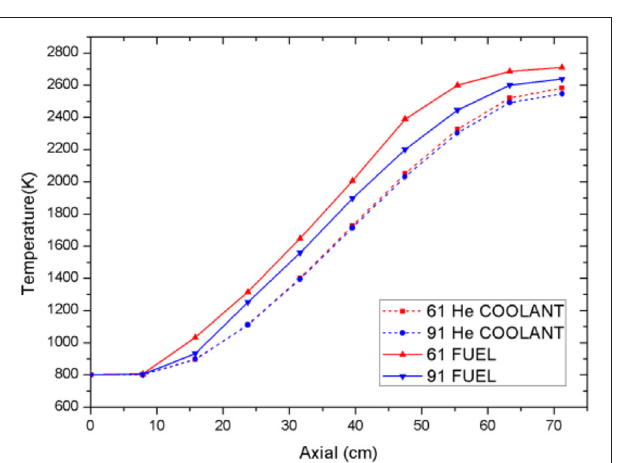
FIGURE 12 | Axial temperature distribution of hot channel.